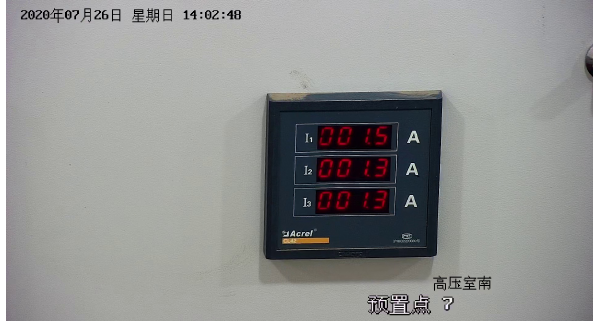
Figure 7. Original image (2).